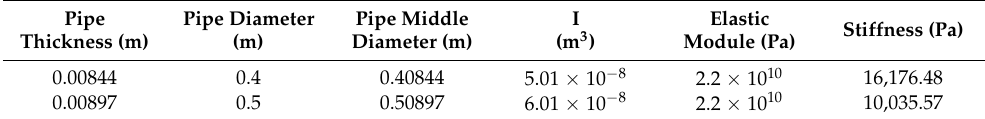
Table 4. Theoretical initial ring stiffness for the plain GFRP